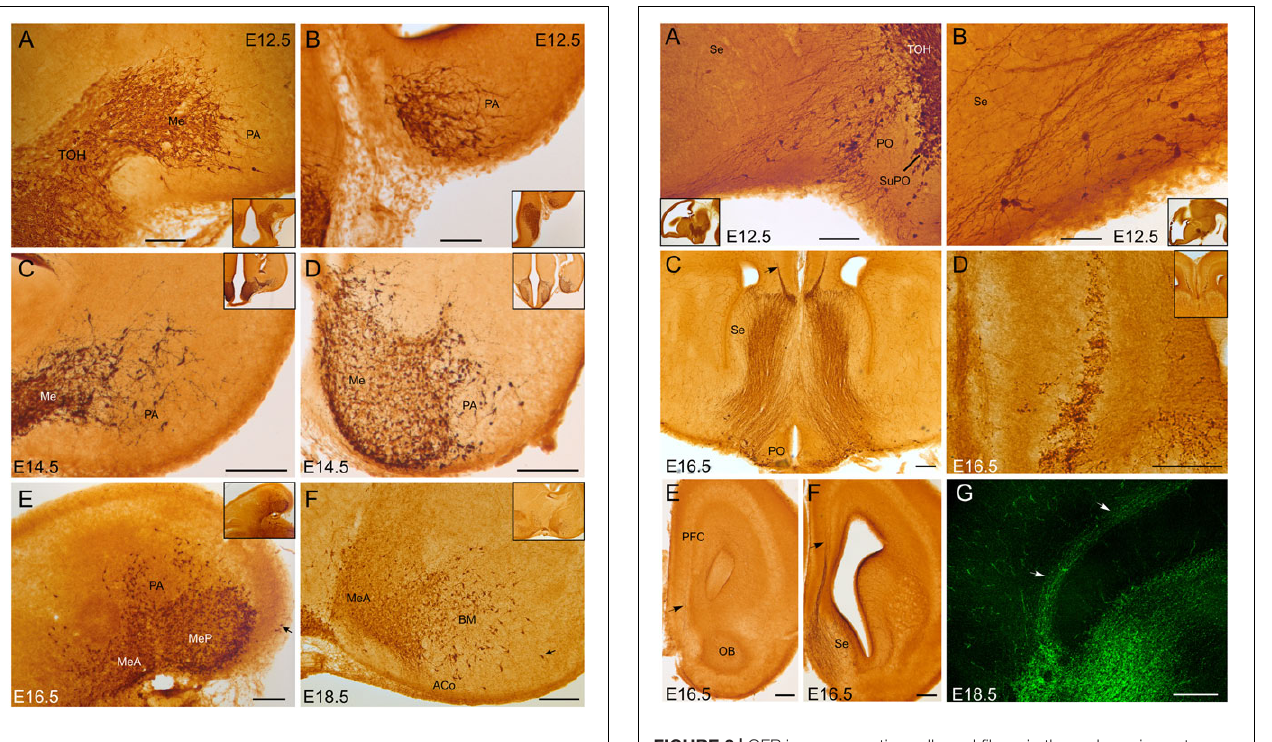
FIGURE 1 | GFP immunoreactive cells in the embryonic amygdala. Images of brain sections of Otp-eGFP embryonic mice (E12.5 to E18.5), showing GFP immunoreactive cells in the developing amygdala. Note the continuity of pallial amygdala (PA) cells with those in the medial amygdala, which originate in the telencephalon-opto-hypothalamic domain (TOH). Panels (A–D,F) are frontal sections, while panel (E) is a horizontal section (for orientation, general views of the sections are shown in insets; in panel (E) , the posterior pole is to the right, and the medial side to the bottom). See text and abbreviation list for more details. Scale bar: panels (A–D) = 100 µ m. Panels (E,F) = 200 µ m.